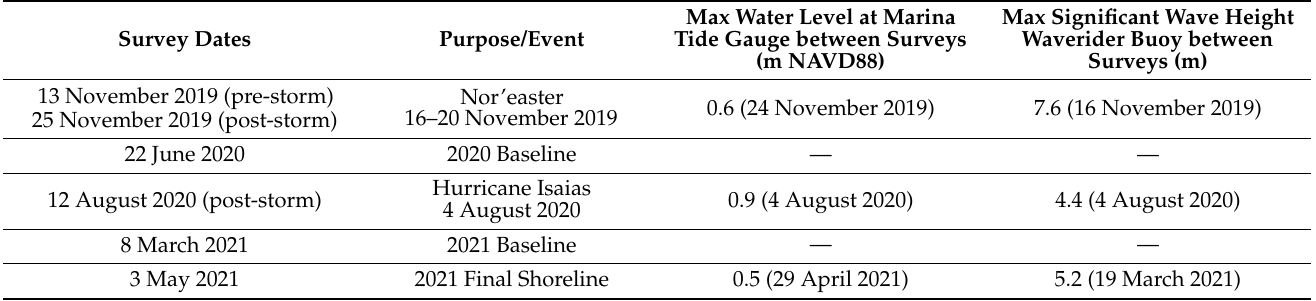
Table 1. Dates of shoreline surveys